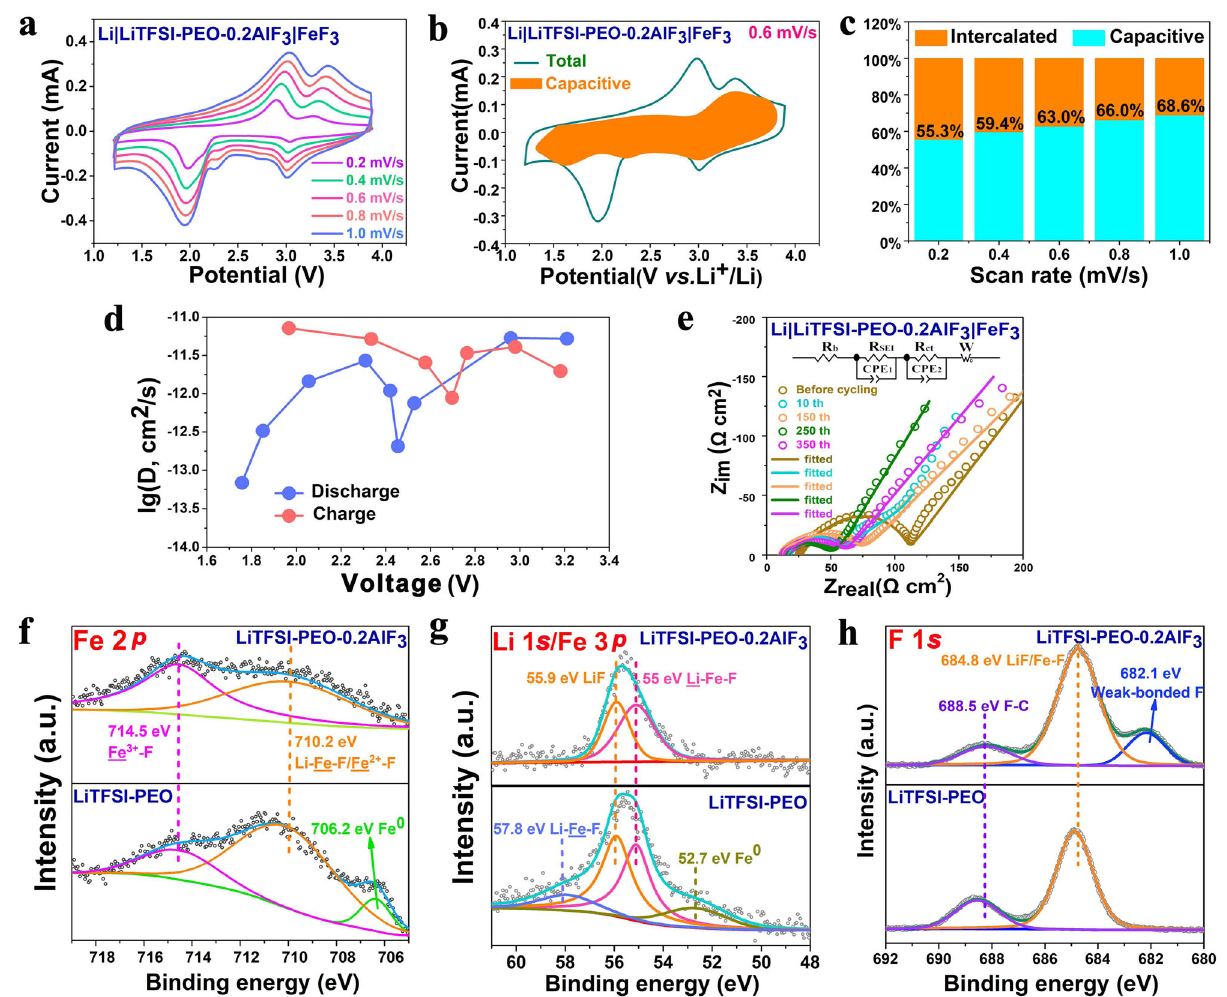
Fig. 7 | Kinetic performance of fl uorinated-polymer-based Li||FeF 3 cells and surface composition of cathode side. a CV curves of Li|LiTFSI-PEO-0.2AlF 3 |FeF 3 cells at different scan rates from 0.2 to 1mV/s between 1.2 and 3.9V. b Typical CV curve of Li||FeF 3 cell at 0.6mV/s with the capacitive currents (k 1 v) outlined in orange area according to i ( V )= k 1 v + k 2 v 1/2 . c Histograms of charge storage con- tributions of capacitance and intercalation processes under different scan rates. d Evolution of diffusion coef fi cient (D) estimated by GITT as a function of cell voltage during discharge and charge processes. e Nyquist plots of the EIS mea- surementsofLi|LiTFSI-PEO-0.2AlF 3 |FeF 3 cellsatdifferentcyclingstages.Intheinset